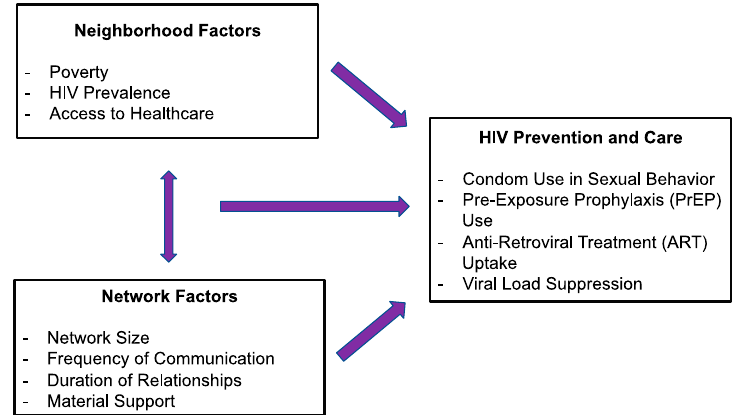
Figure 1. Conceptual framework for the influence of neighborhoods and networks on HIV prevention and care behaviors among Black men who have sex with men (MSM).